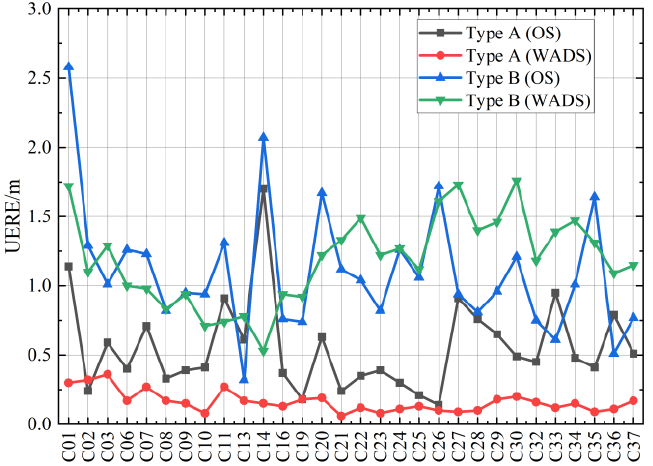
Table 4. The results of the BDS satellite UEREs, as calculated by type A and type B receivers under the OS and the WADS (unit: meter).